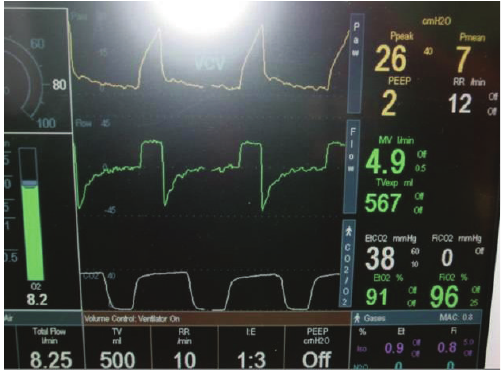
Figure 1: ETCO 2 before